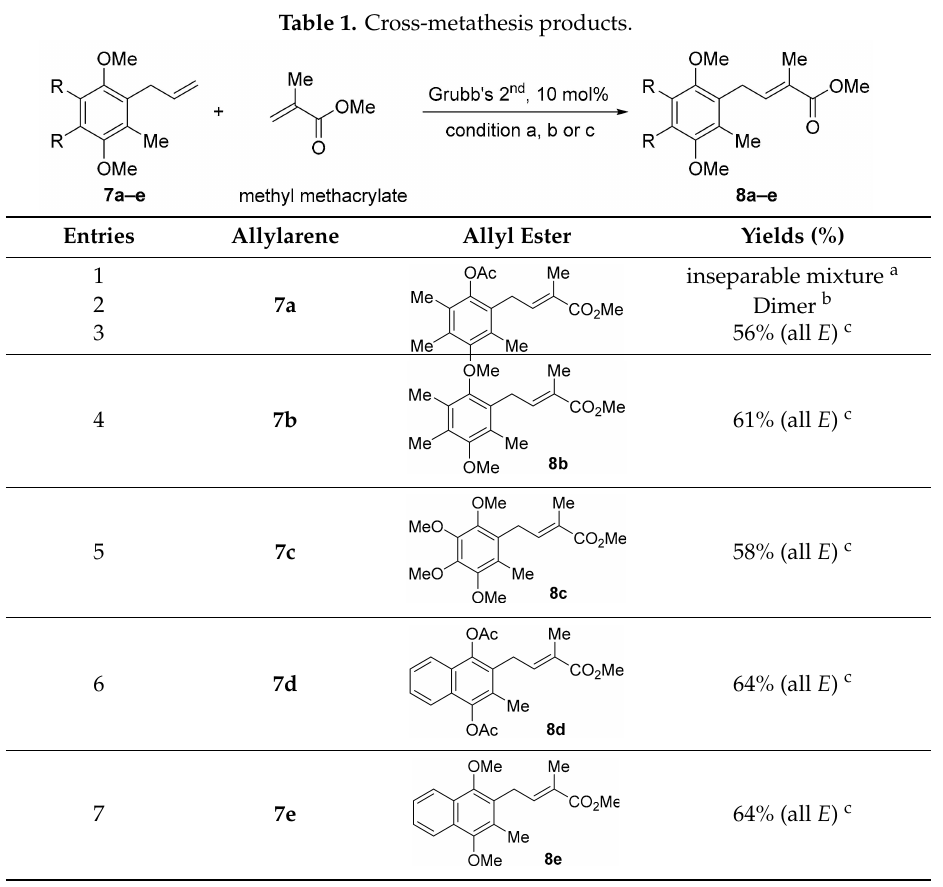
Table 1. Cross-metathesis